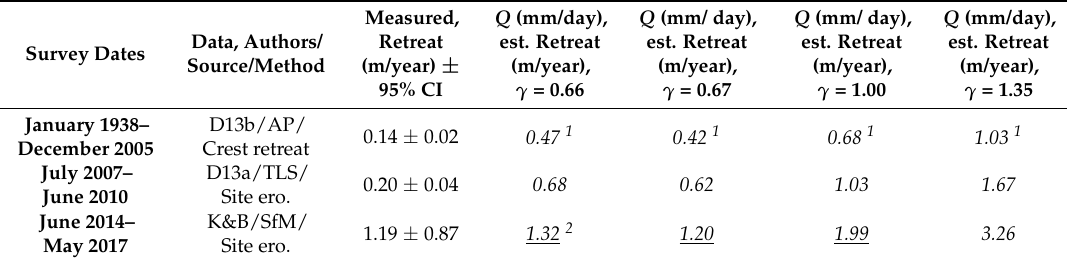
Table A3. Daily discharge ( Q ) estimated bluff erosion magnitude × observed Q (mm/day) frequency (right four columns)—estimated using different daily erosion-discharge power law scaling exponents, gamma—validated against measured retreat rates from Day et al. 2013a (D13a) and 2013b (D13b) and Kelly and Belmont, this paper (K&B) collected data.